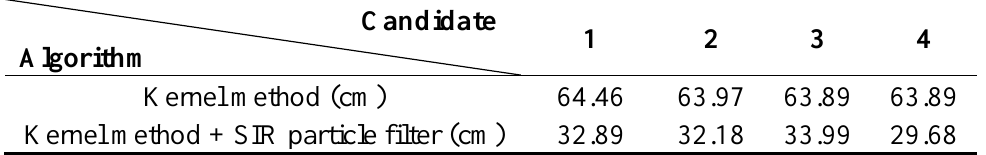
Table 2. Standard deviations of positioning errors of the dynamic test using the kernel method and the kernel method with the SIR particle filter.